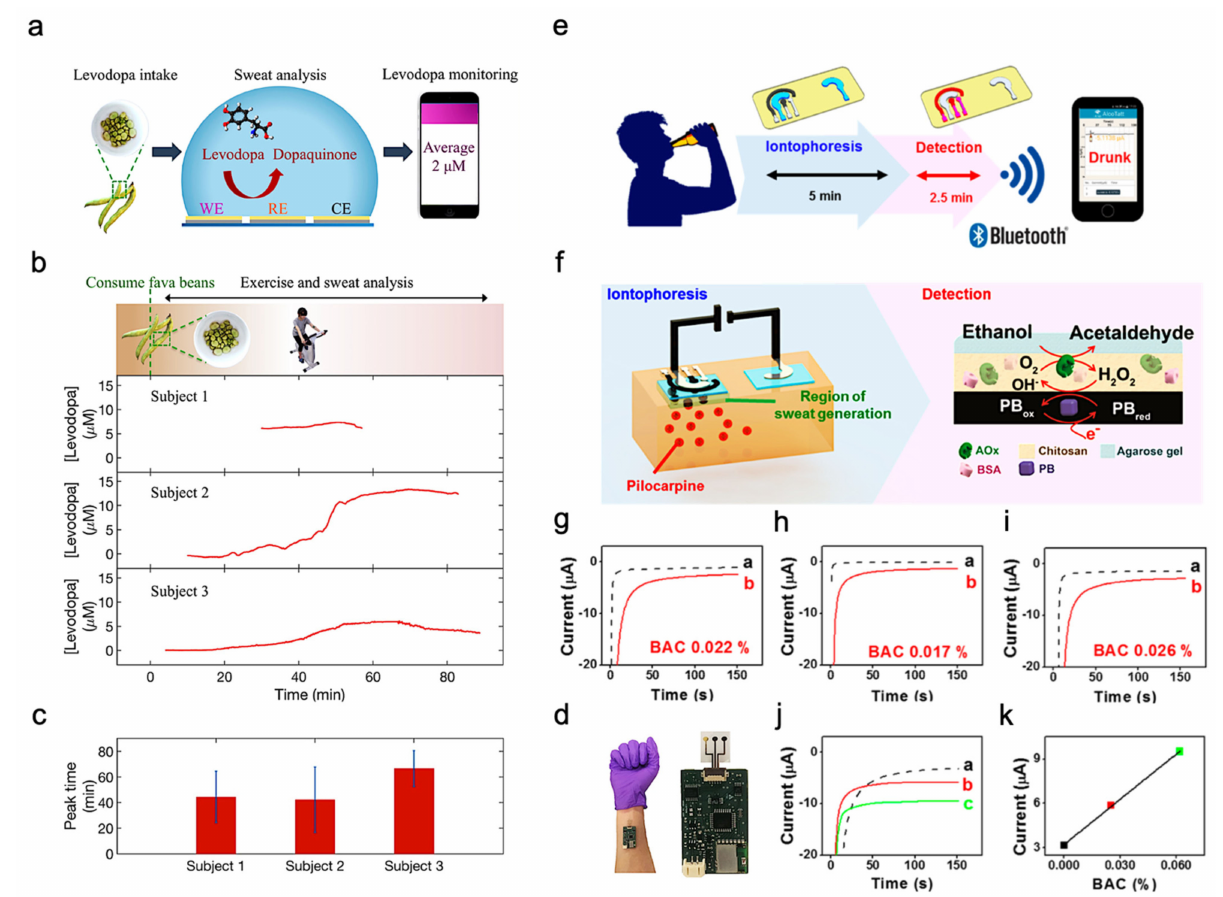
Figure 7. Drug sensing mechanism and ethanol levels measurement. ( a ) Interaction of the sensor with sweat. ( b ) Cycling and sweat analysis. Examples of sweat levodopa concentrations for three different subjects after they consume 450 g of fava beans. ( c ) Averaged time of peak levodopa concentration for three different subjects across multiple exercise trials. ( d ) Optical image of the S-band worn on a subject’s wrist. Reproduced with permission from ref. [99], Copyright from 2019, American Chemical Society. ( e ) Sweat ethanol sensor used to send alerts to a smart device. ( f ) Schematic diagram of constituents in the iontophoretic system (left) and of the reagent layer and processes involved in the amperometric sensing of ethanol on the working electrode (right). ( g – i ) Experiments with consumption of 12 oz of beer measured from three different human subjects before (plot “a”) and after drinking alcohol beverage (plot “b”). ( j ) Chronoamperograms obtained from a: BAC 0%, b: BAC 0.025% and c: BAC 0.062%. ( k ) Correlation between current response and the BAC level. Reproduced with permission from ref. [101], Copyright from 2016, American Chemical